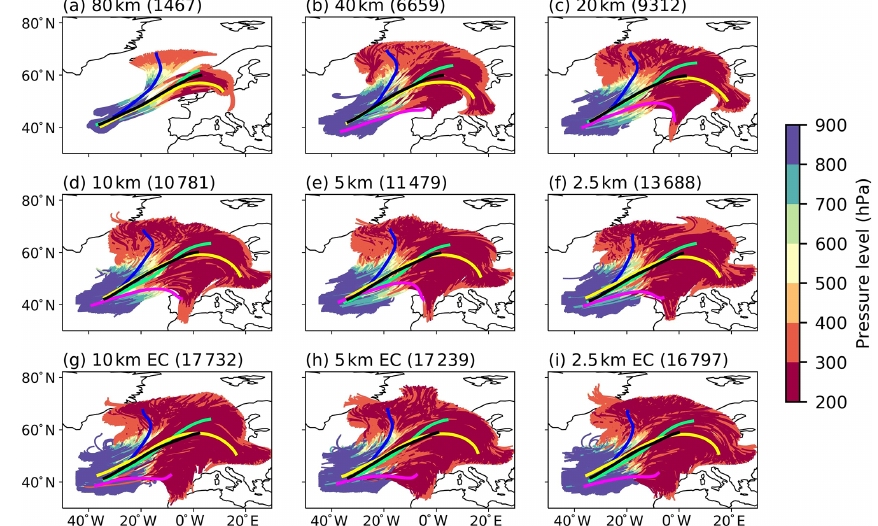
Figure 2. WCB trajectories identified from 48h forward trajectories depending on horizontal grid spacing. The lower row (g–i) shows simulations for explicit convection (indicated by EC). The number in the brackets gives the number of WCB trajectories. Trajectories are colored according to their pressure level. The thick colored lines represent the mean path of different subclasses of trajectory, namely Trajectory 1 (blue), Trajectory 2 (green), Trajectory 3 (yellow) and Trajectory 4 (magenta). The mean of all trajectories is shown in black. All simulations use the one-moment cloud